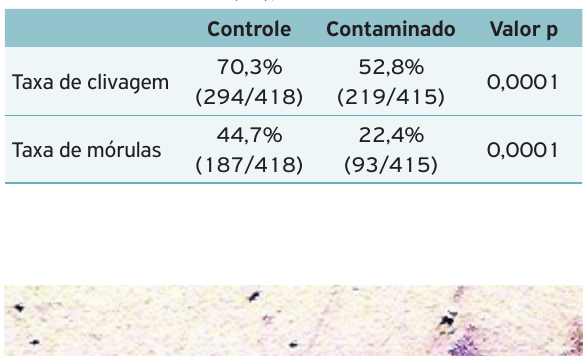
Tabela 1. Desenvolvimento embrionário dos grupos controle e contaminado. São Paulo (SP), 2009.